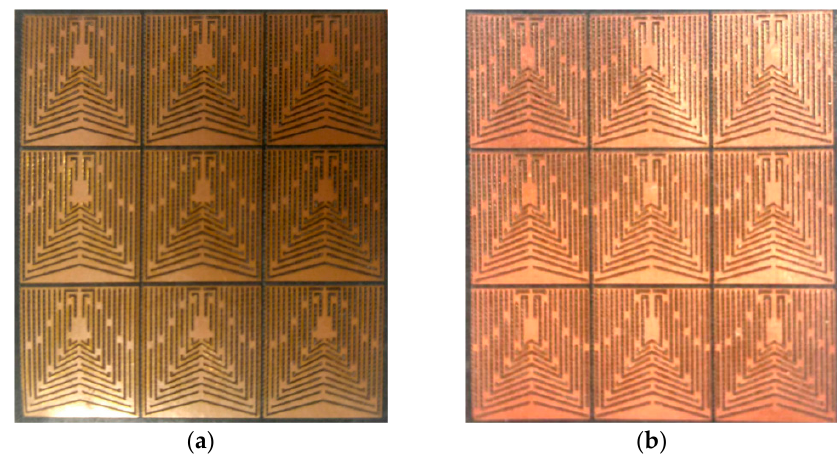
Figure 13. Fabricated images of the proposed tag with two different bit combinations: ( a ) 11001100110011001100 and ( b ) 00110011001100110011.